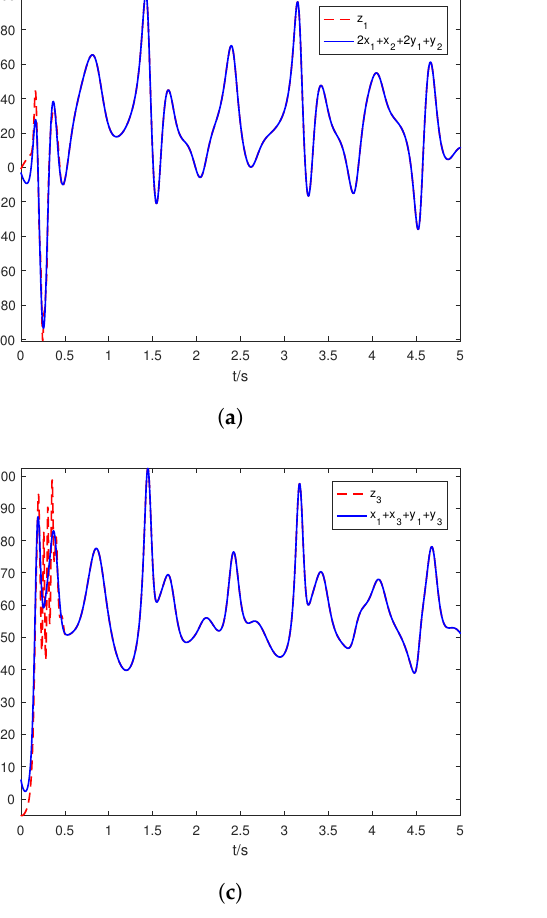
Figure 16. The synchronization for state variables z 1 and 2 x 1 + x 2 + 2 y 1 + y 2 , z 2 and x 1 + x 3 + y 1 + y 3 , z 3 and x 1 + x 3 + y 1 + y 3 , z 4 and x 2 + 2 x 3 + y 2 + 2 y 3 of drive systems (43), (44) and response system (45) indicating in sub-pictures ( a – d ),